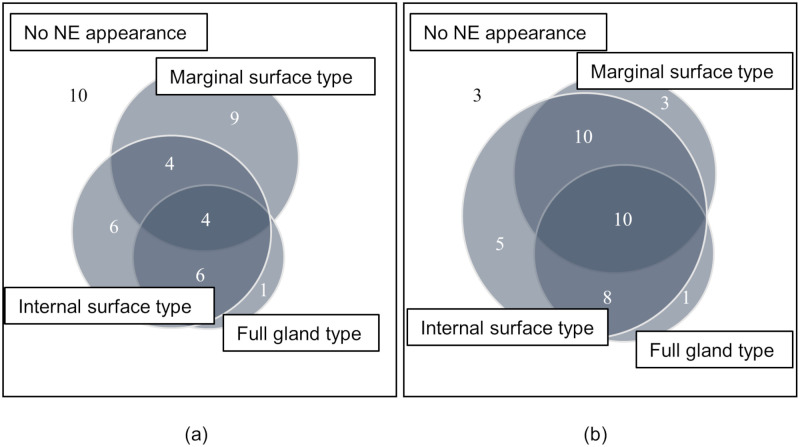
Venn diagrams depicting occurrence patterns of NE in the infection group and the eradication group.(a) Helicobacter pylori (HP)-infected GCs. (b) HP-eradicated GCs.